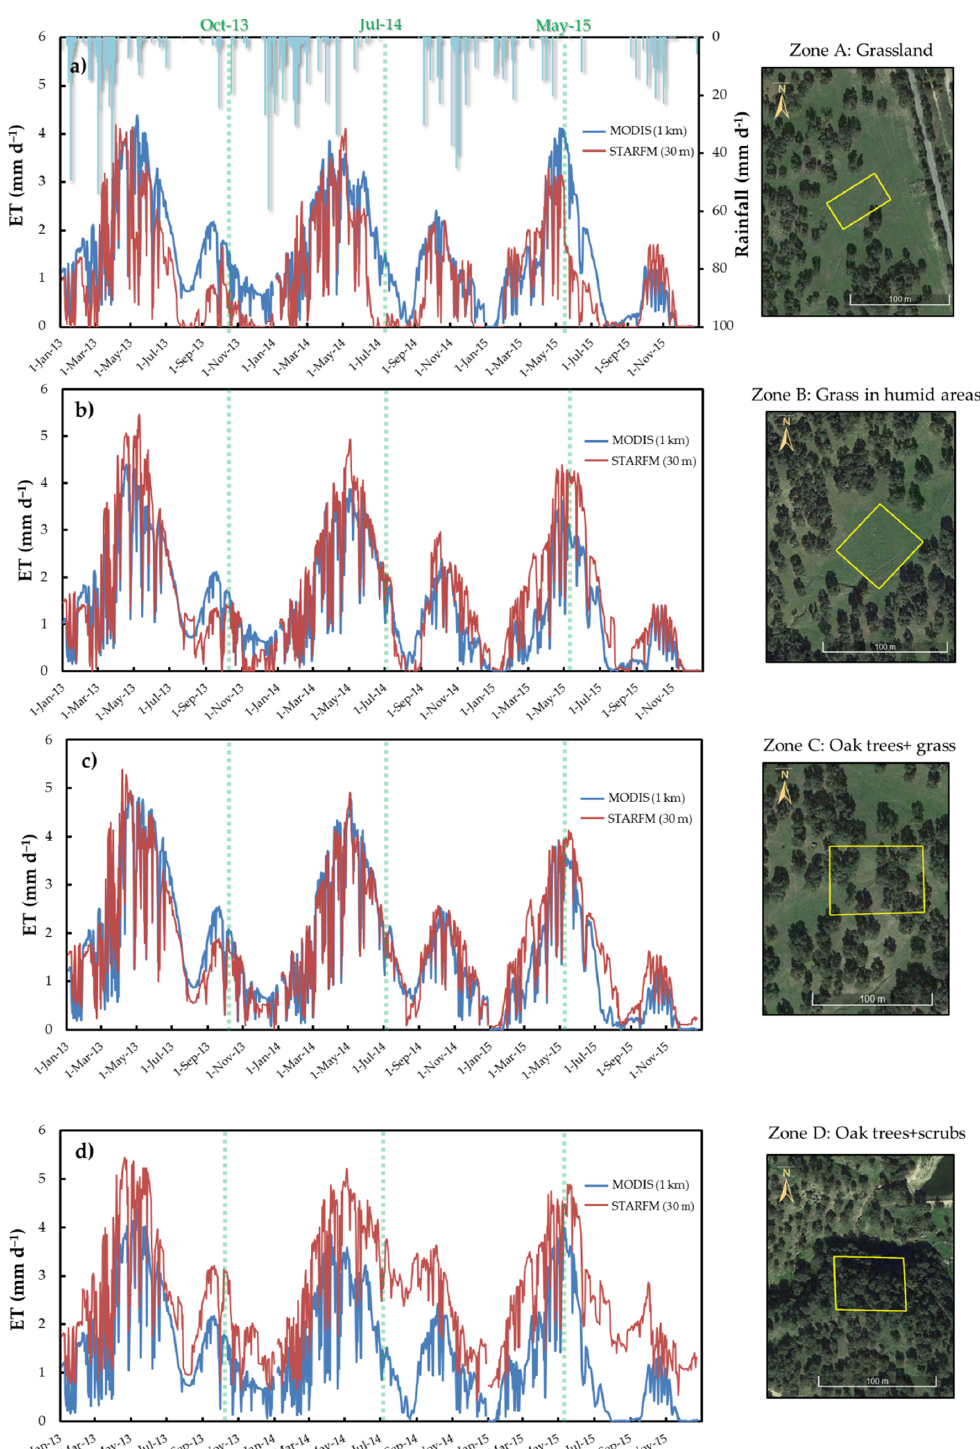
Figure 7. Evolution of daily ET generated by DisALEXI/MODIS (1 km) and STARFM (30 m) over an area (denoted by the yellow polygons) of grassland ( a ), of grass in humid areas ( b ), of combined oak tree and grassland ( c ) and of oak trees and scrub ( d ). The green vertical dashed lines correspond to dates that are analyzed in Section 3.4.